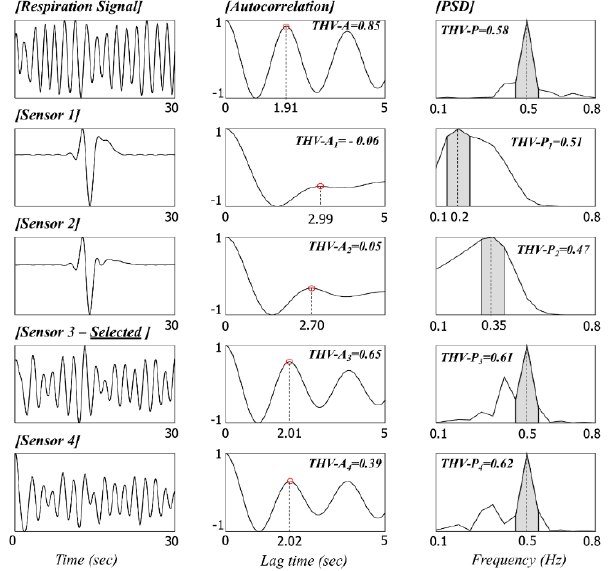
Figure 8. Signal quality check based on THV-S and sensor selection for BR analysis (There are motion artifacts in the signals from sensors 1 and 2, and they were eventually excluded in the following sensor selection by the lower THV-S).